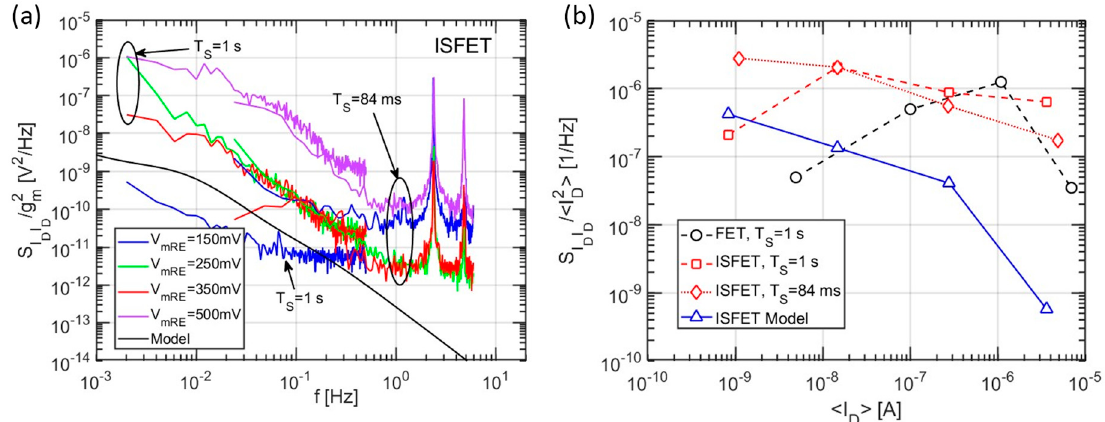
Figure 12. ( a ) comparison of the input voltage referred noise PSD at the sensing layer obtained from experiments and from the circuit simulation of Figure 7. ( b ) Normalized PSD at 0.1 Hz for FET and ISFET configuration of the same device, together with the ISFET model results in ( a ).